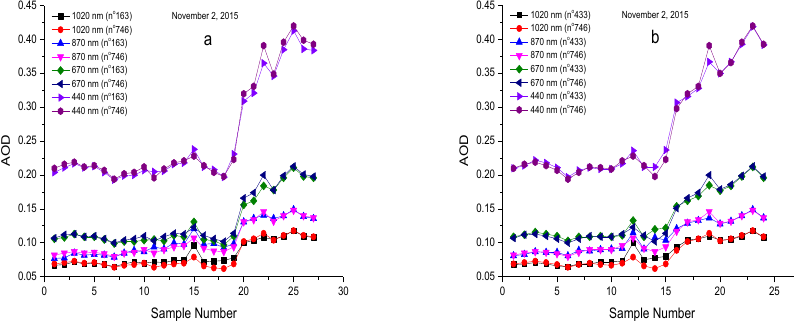
Figure 2. Comparison of the result of AOD retrieved at 1020 nm, 870 nm, 670 nm and 440 nm from the measurements of ( a ) n°163 and n°746, and ( b ) n°433 and n°746.